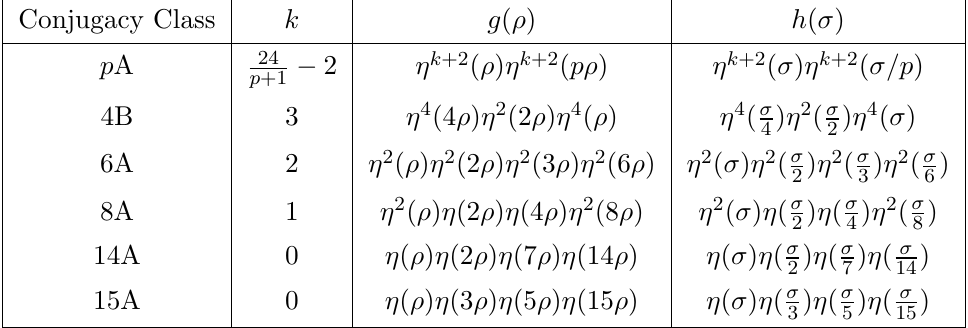
Table 4 . Factorization of ~(cid:8) k ( (cid:26); (cid:27); v ) as lim v ! 0 as shown in, p 2 f 1 ; 2 ; 3 ; 5 ; 7 ; 11 g